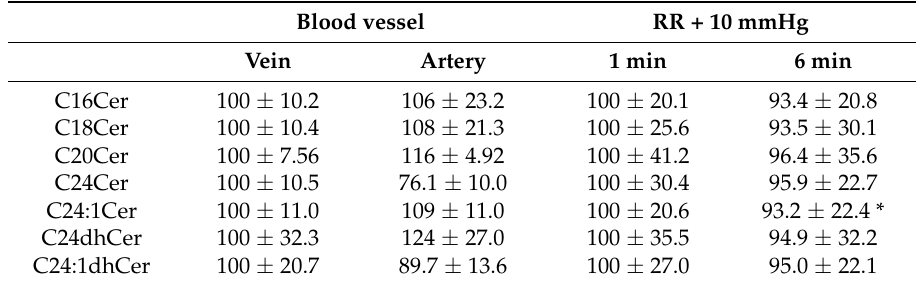
Mean (in %) ± SD; Blood vessel: Heparin, n = 3 (C20Cer: n = 2); RR + 10 mmHg: EDTA, n = 4; Paired t test; * p < 0.05.